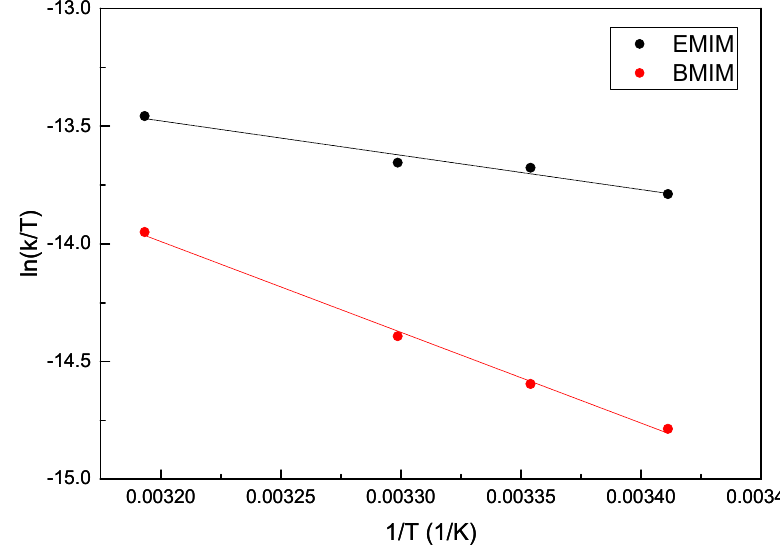
Figure 8. Plots of ln ( k / T ) versus 1/ T using the second-order rate constants obtained from Equation (10) for the two aerogels.